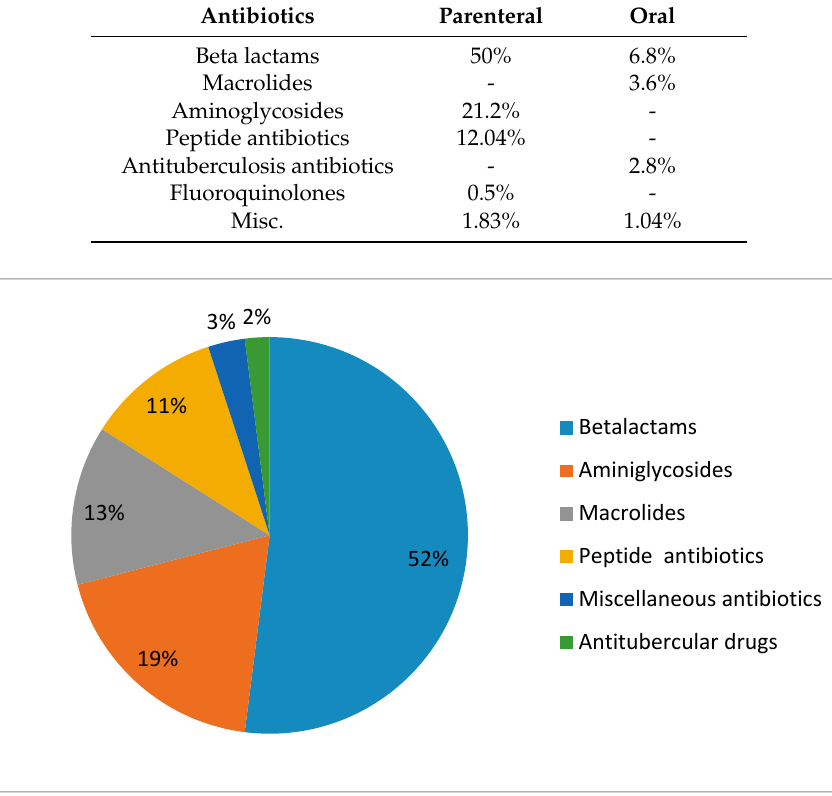
Table 3. Total encounter with injectable and oral route of administrations.